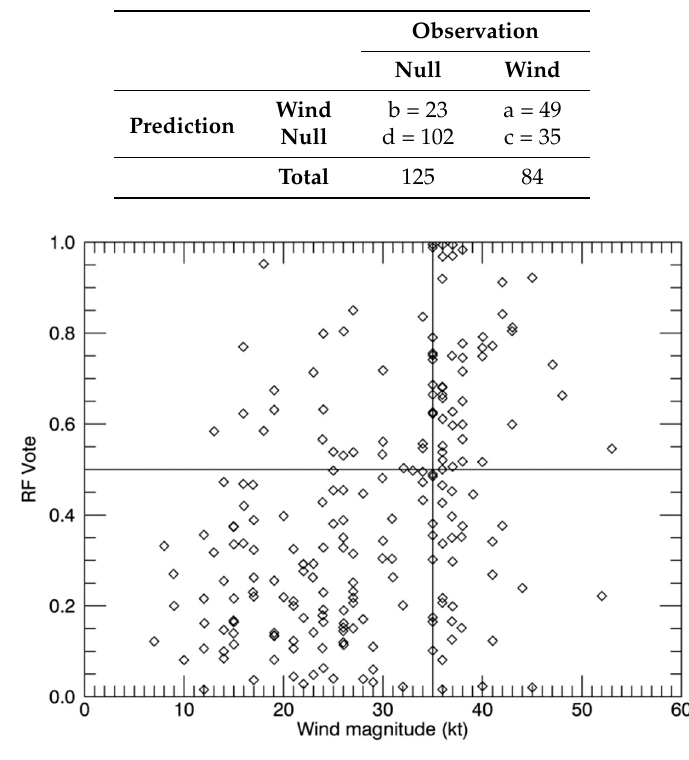
Table 2. Random forest out-of-bag confusion matrix.